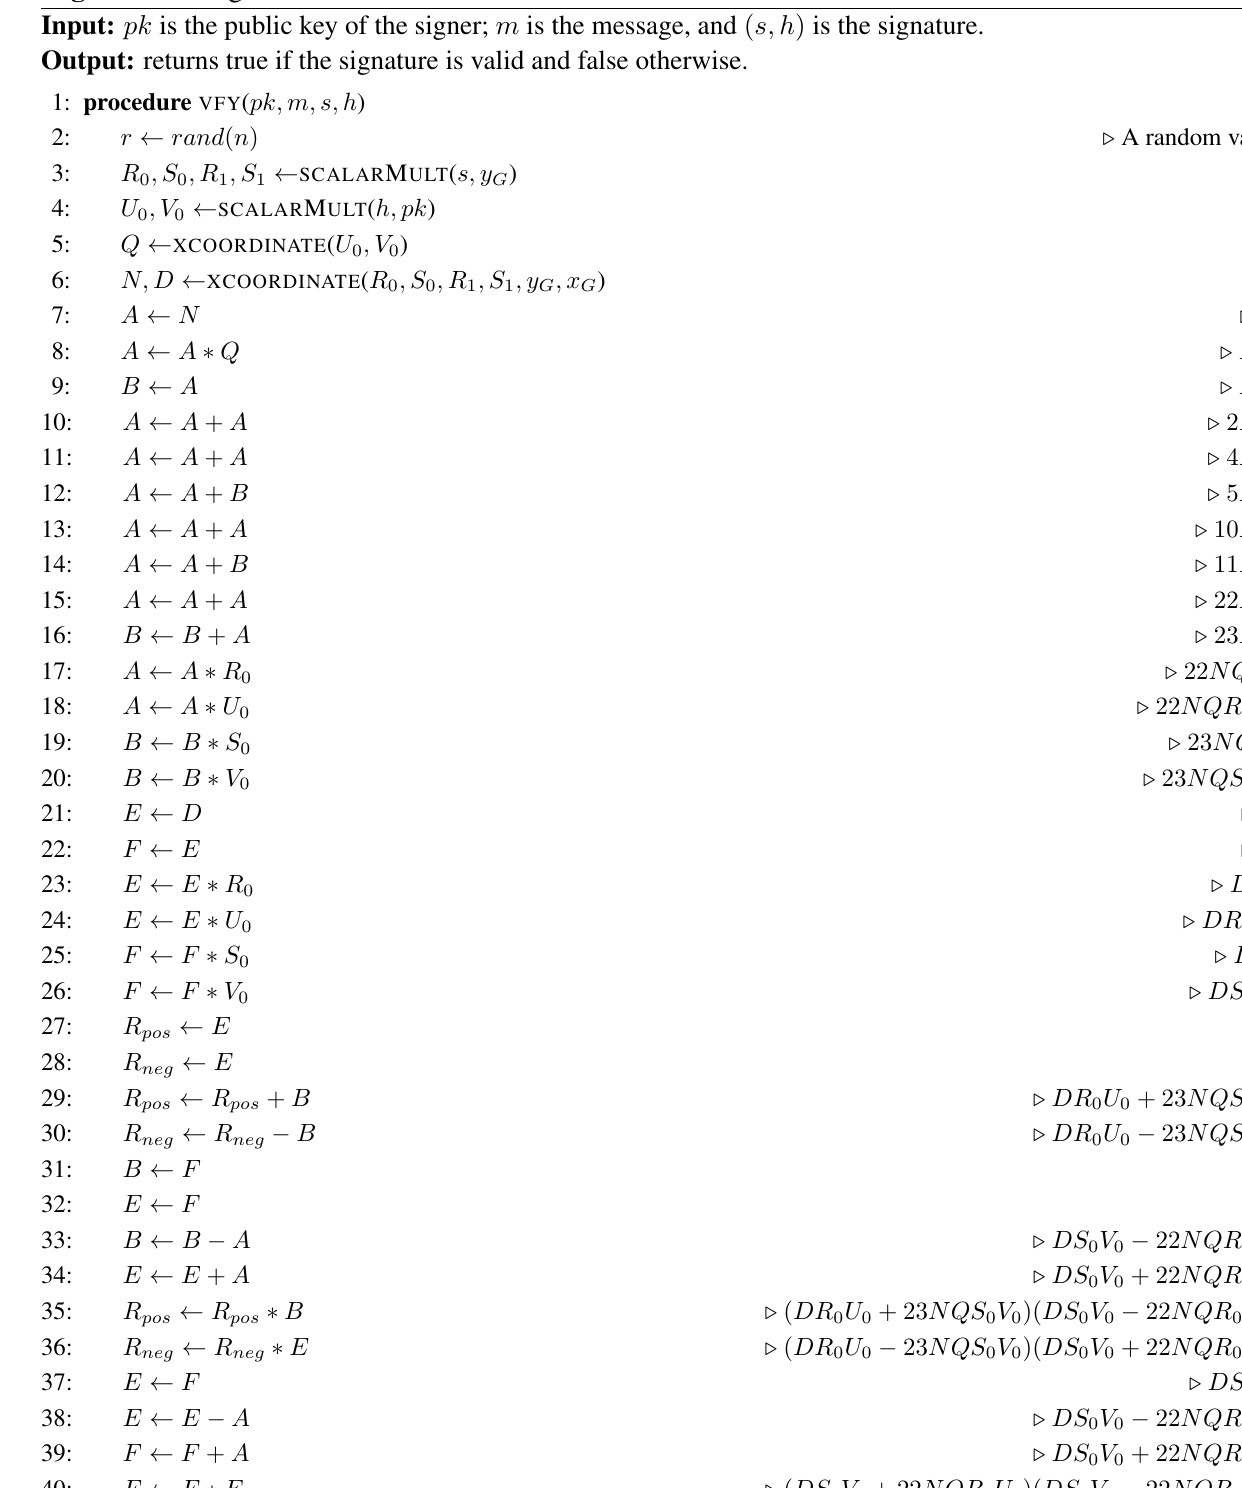
Algorithm 7 Signature